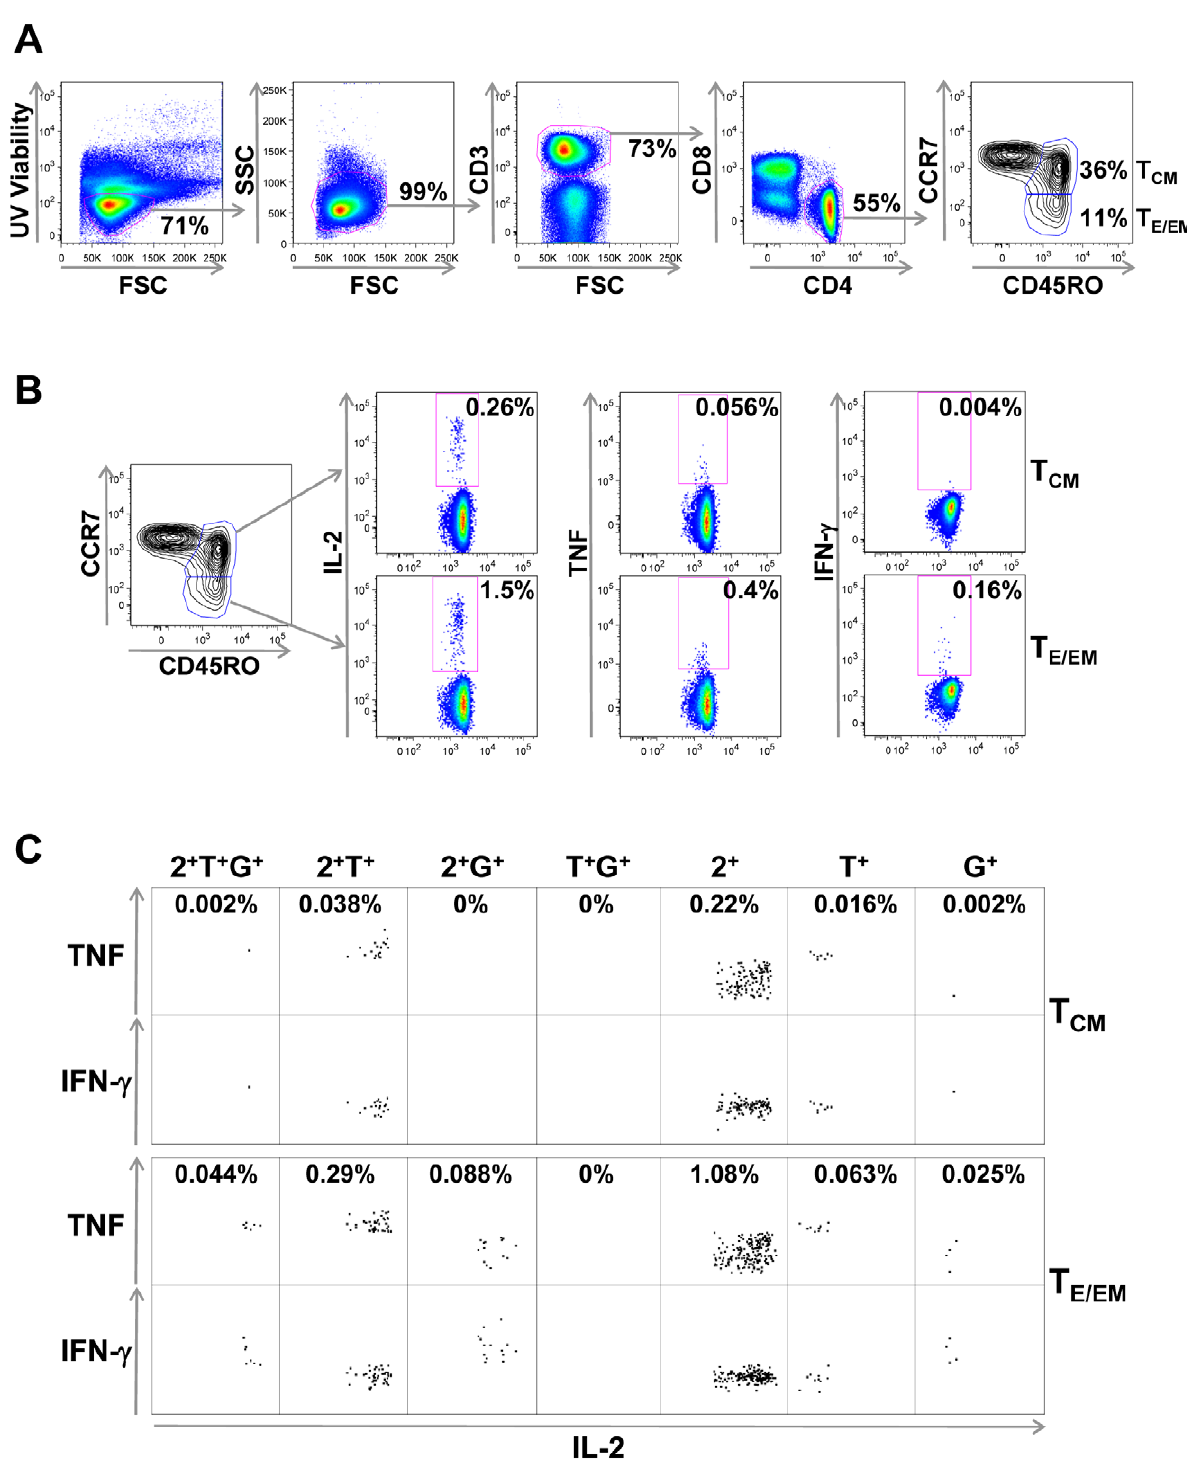
Figure 1. Identification of RTS,S vaccine-induced CSP-specific CD4 + T cell memory subsets. PBMCs from an RTS,S-immunized volunteer were stimulated in vitro for 18 h with anti-CD28 and anti-CD49d plus a pool of 2 long contiguous CSP peptides in the presence of PE-conjugated anti- CCR7 Ab. Cells were harvested and surface-labeled for CD3, CD4, CD8, CD45RO and UV viability dye and then stained intra-cellularly for IL-2, TNF- a and IFN- c . Cells were acquired on an LSR-II flow cytometer and analyzed using FlowJo. (A) Gating strategy used to identify CD4 + CD45RO + CCR7 + T CM and CD4 + CD45RO + CCR7 2 T E/EM cells. Numbers indicate the percentage of cells in each gate. (B) Detection of IL-2, TNF- a and IFN- c production by CD4 + T CM and CD4 + T E/EM cells. Numbers indicate the percentage of cytokine + cells for each memory cell type. (C) Boolean gating analysis was used to divide cytokine-producing cells into seven distinct populations based on their production of IL-2 (2), TNF- a (T) and IFN- c (G) in any combination. Each population is shown as two dot plots: the upper is TNF- a vs IL-2 and the lower is IFN- c vs. IL-2. Numbers indicate the percentage of cytokine + cells for each memory subtype.